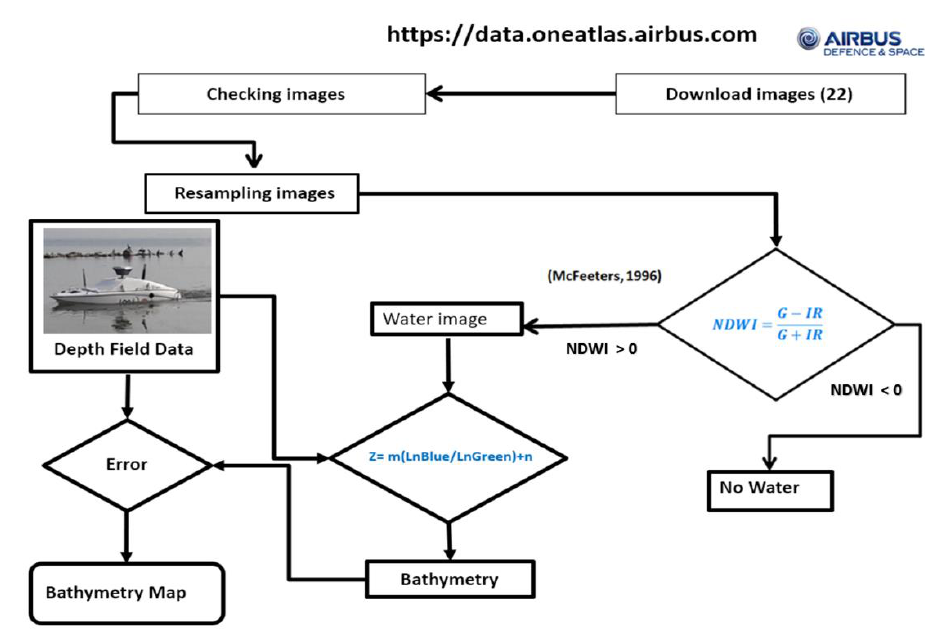
Figure 7. Workflow diagram with Pleiades images.